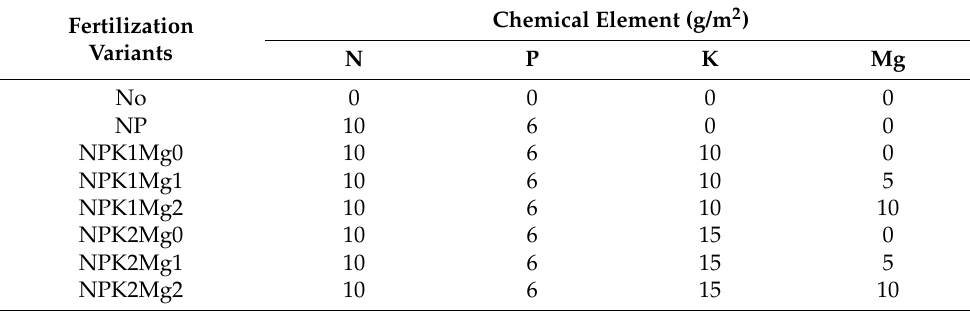
Table 2. Mineral fertilization treatments and rates in the microplot field experiment.